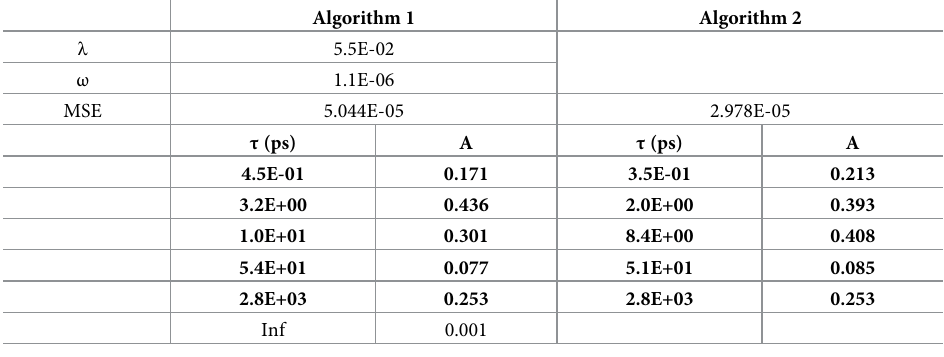
Table 2. Kinetic parameters ( τ and A) predicted from the fluorescence kinetic data by Algorithm 1 and Algorithm 2 (5